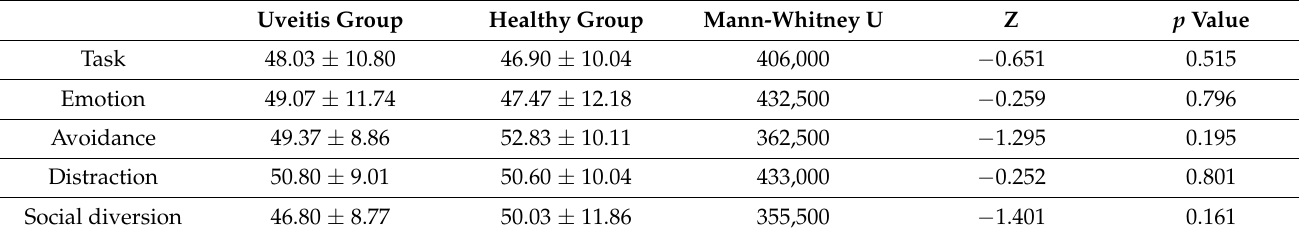
Table 4. Differences scores between groups found in CISS.